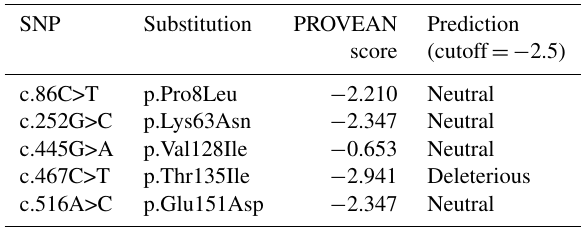
Table 6. Effect of non-synonymous substitutions on the function of buffalo κ -CN.